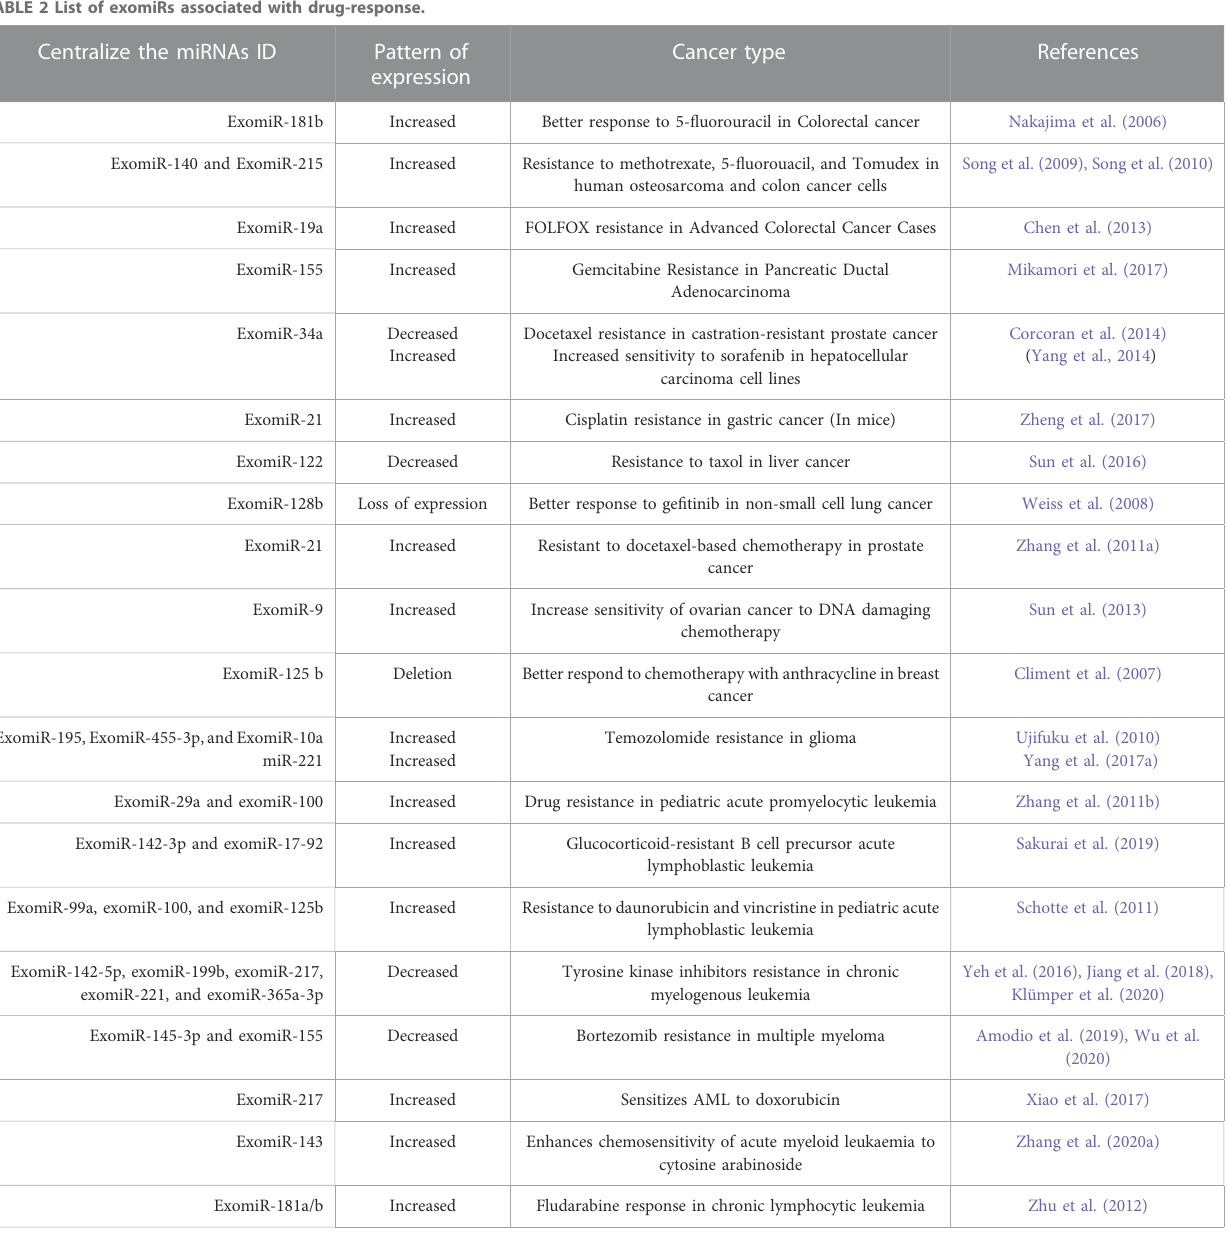
TABLE 2 List of exomiRs associated with